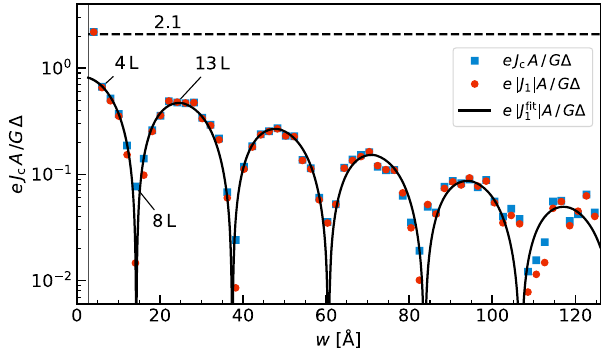
Fig. 6 Dependence of the supercurrent on Nb thickness. Comparison of critical current density, J c ¼ max the absolute value of fi rst Fourier component for supercurrent, ∣ J1 ∣ [see Eq. (5), red circles], and its fi tting j J fit these quantities are “ normalized ” by normal-state conductance, G